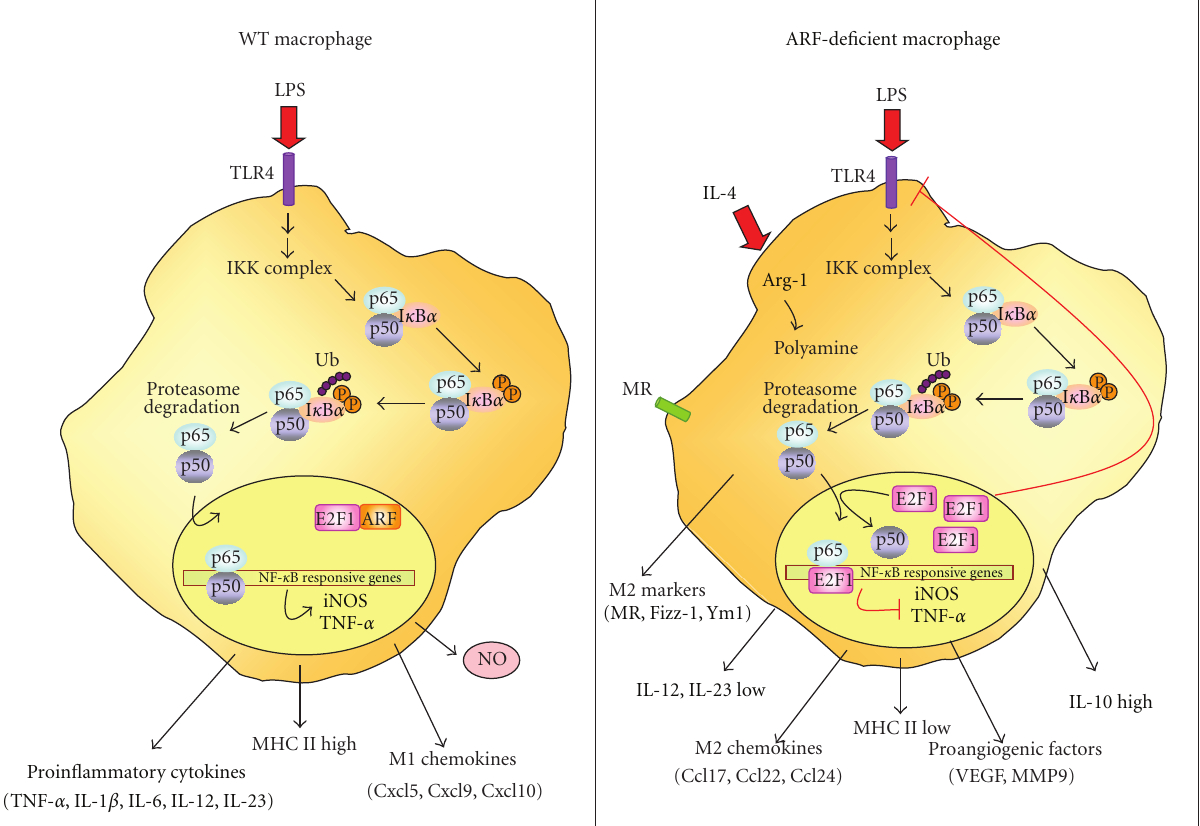
Figure 2: Alternative activation in ARF-deficient macrophages. In WT macrophages, a balance between M1 and M2 phenotype is established, depending on stimuli. Inflammatory stimuli induce NF- κ B signaling pathways through the phosphorylation and subsequent ubiquitin- dependent degradation of I κ B α by the 26S proteasome. Then, NF- κ B translocates to the nucleus inducing target gene expression. ARF present in the nucleus displays physical and functional interaction with E2F1 resulting in destabilization of E2F1 protein and activation of NF- κ B. However, ARF-deficient macrophages establish an immunosuppressive and tolerant microenvironment via impairment of M1 signals. When NF- κ B translocates to the nucleus, excessive E2F1 inhibits NF- κ B by binding to its subunit p65 in competition with the heterodimeric partner p50. Moreover, excessive E2F1 may inhibit transcriptional expression of TLRs. This leads to secretion of M2 chemokines Ccl17 and Ccl22, release of the anti-inflammatory cytokine IL-10, and stimulation of angiogenesis through expression of VEGF and